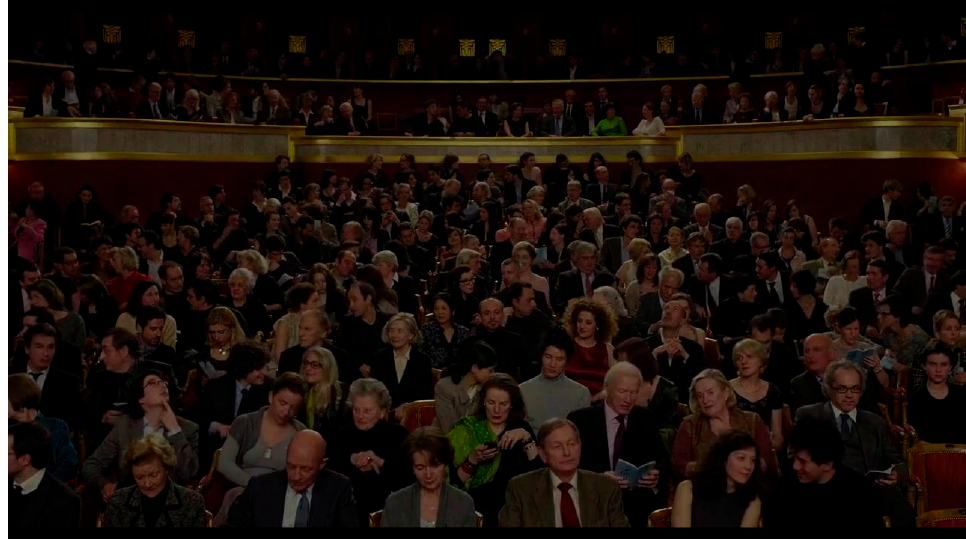
Figure 2. The story of Georges and Anne begins.